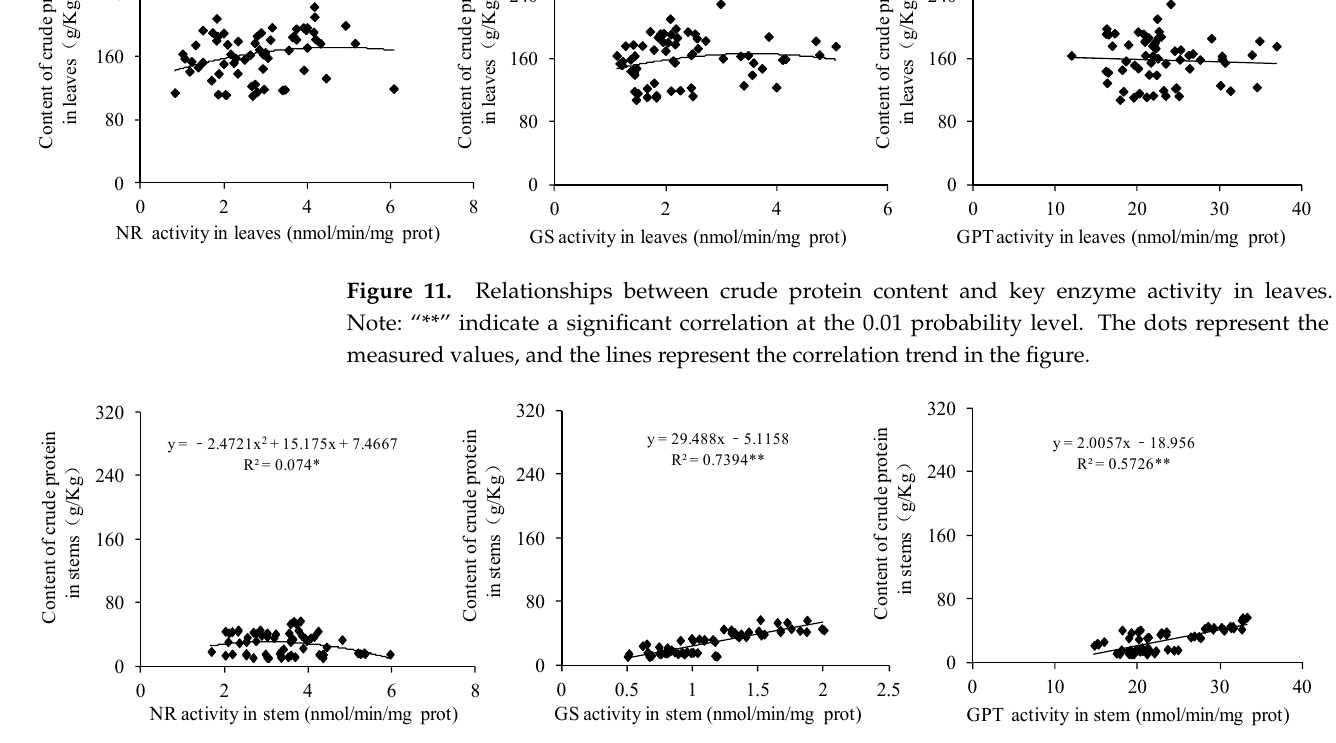
Figure 12. Relationships between crude protein content and key enzyme activity in stems. Note: “*” and “**” indicate the significant correlation at the 0.05 and 0.01 probability level, respectively. The dots represent the measured values, and the lines represent the correlation trend in the figure.